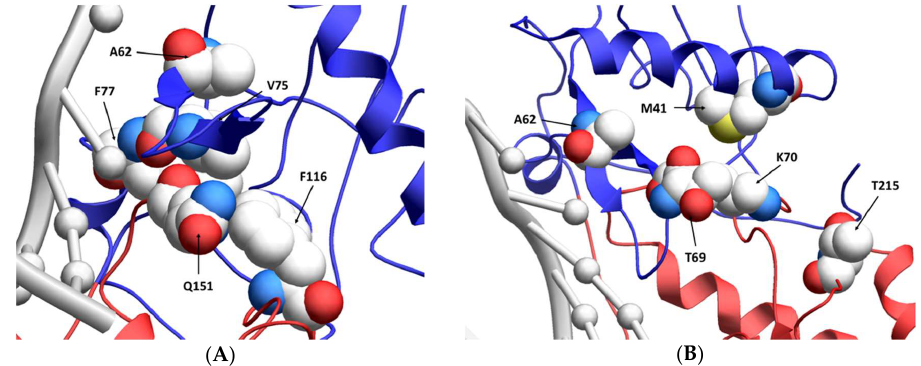
Figure 6. Location of resistance-conferring amino acid residues in multi-drug-resistant HIV-1 reverse transcriptase. A ribbon structure of the covalently trapped catalytic complex of HIV-1 RT [34] with the multi-dideoxynucleoside resistant (MDR) Q151M complex amino acid residues shown in a close-up view ( A ). The MDR T69SSS insertion complex amino acid residues are shown in a close-up view ( B ). A portion of the HIV-1 RT p66 subunit is shown with color-coding of subdomains: fingers (blue) and palm (red). The template and primer DNA strands are shown in light gray. While the p66 subunit contains the DNA-binding groove and the polymerization active site, the non-catalytic p51 subunit is not shown [35]. Image obtained from the “Research Collaboratory for Structural Bioinformatics Protein Data Bank” [36] (Protein Data Bank identifier: